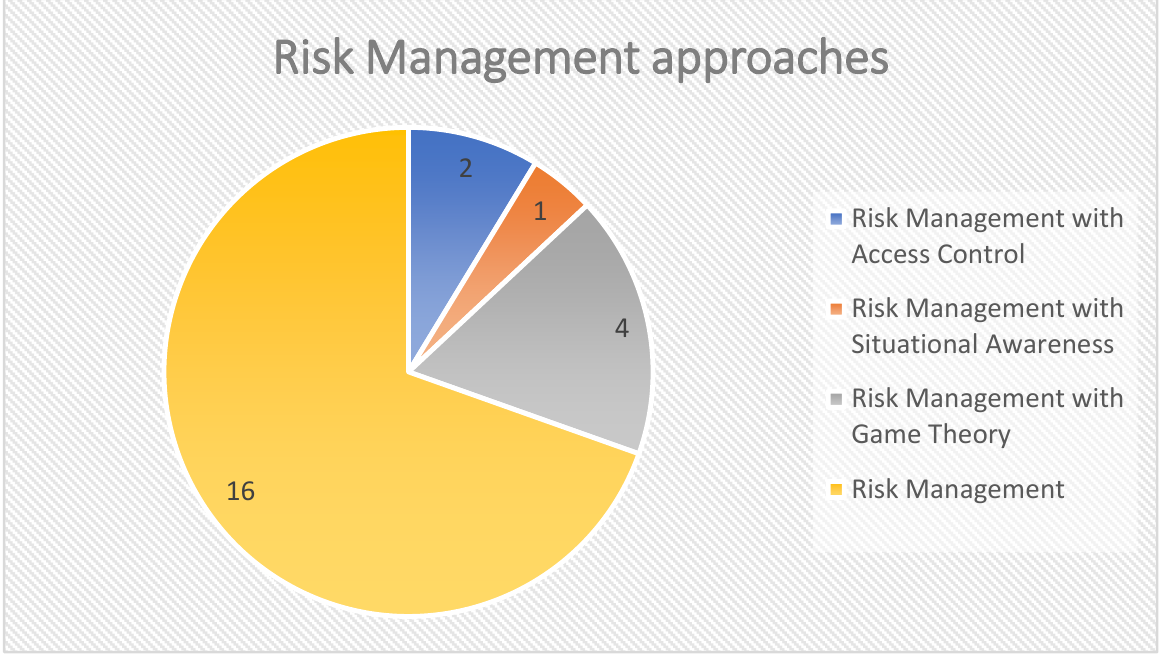
Figure 9. Risk management approaches.